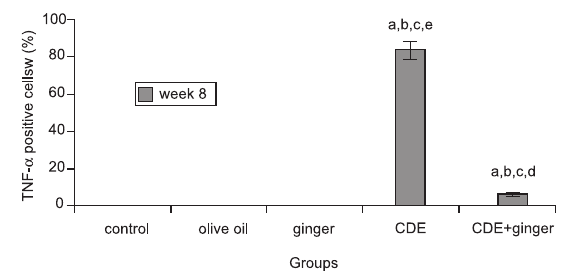
Figure 5 - The effect of ginger extract on TNF- α expression in rats with induced liver cancer. The graph shows the positive expression of TNF- α based on the different diets given. a = p ≤ 0.05 compared with eight-week control group; b = p ≤ 0.05 compared with olive oil group; c = p ≤ 0.05 compared with ginger group; d = p ≤ 0.05 compared with CDE group; e = p ≤ 0.05 compared with CDE+ginger group